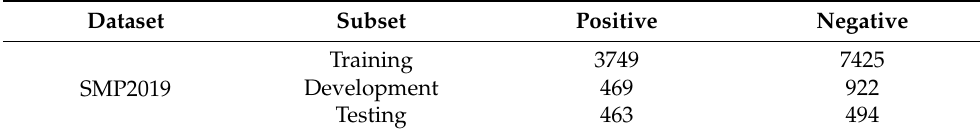
Table 1. The proportions of the implicit experimental dataset for SMP2019. Dataset